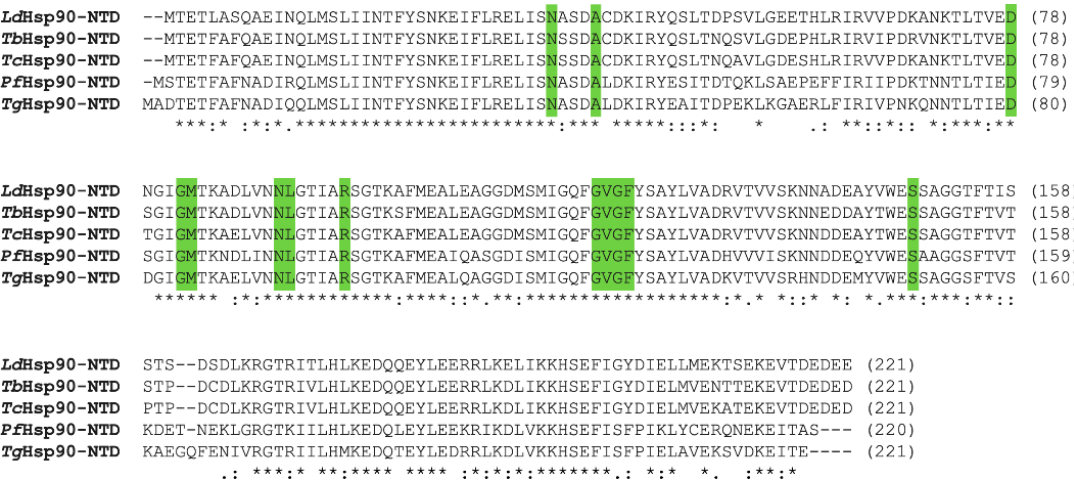
Figure 3. Sequence alignment among the HSP90-NTDs of various parasites (UniProtKB codes Ld HSP90: F1CCS2; Tb HSP90: Q389P1; Tc HSP90: P06660; Pf HSP90: Q8IC05; Tg HSP90: Q7Z1F7) performed with Clustal Omega. Amino acids involved in ATP binding are highlighted in green. Conserved residues are indicated by asterisks, whereas residues with similar and weakly similar properties are indicated by colons and dots, respectively (below the residues).